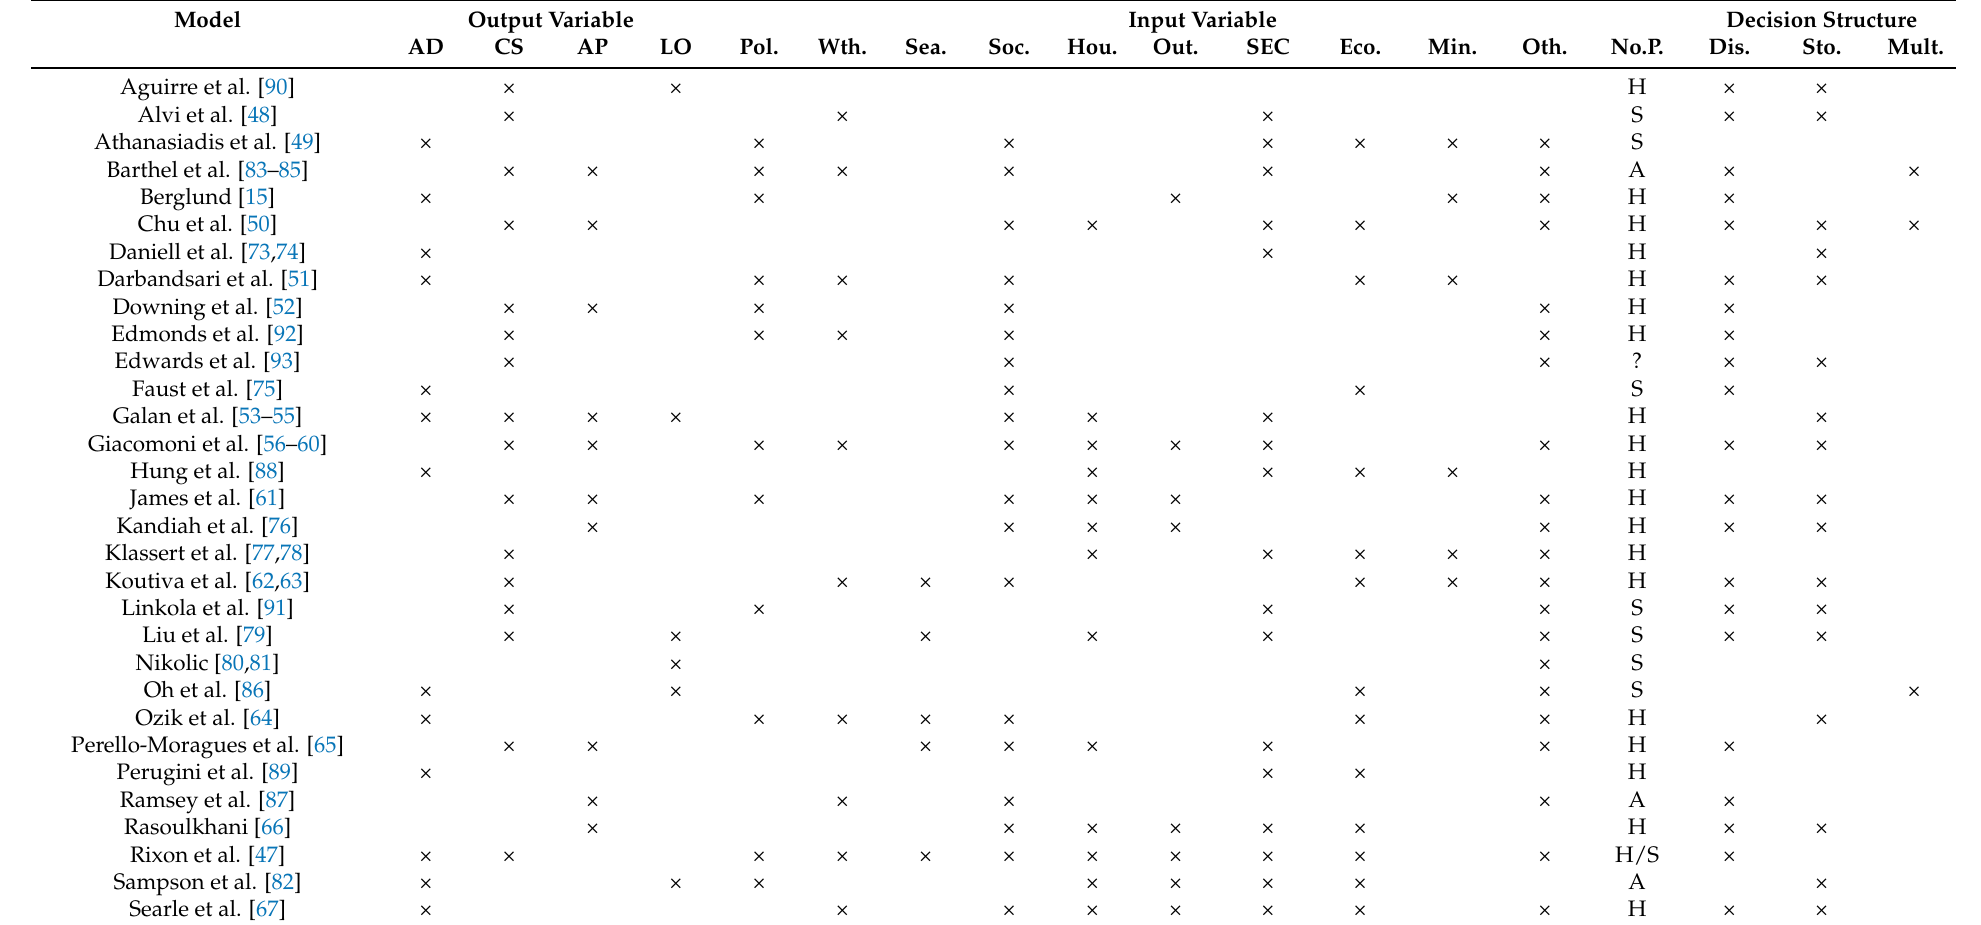
Table 7. Output variables, input variables and structure of agent decisions. Output variables: AD = aggregated water demand, CS = consumption, AP = appliance, LO = location. Input variables: Pol. = policy, Wth. = weather, Sea. = seasonal or diurnal changes, Soc. = societal influence, Hou. = housing